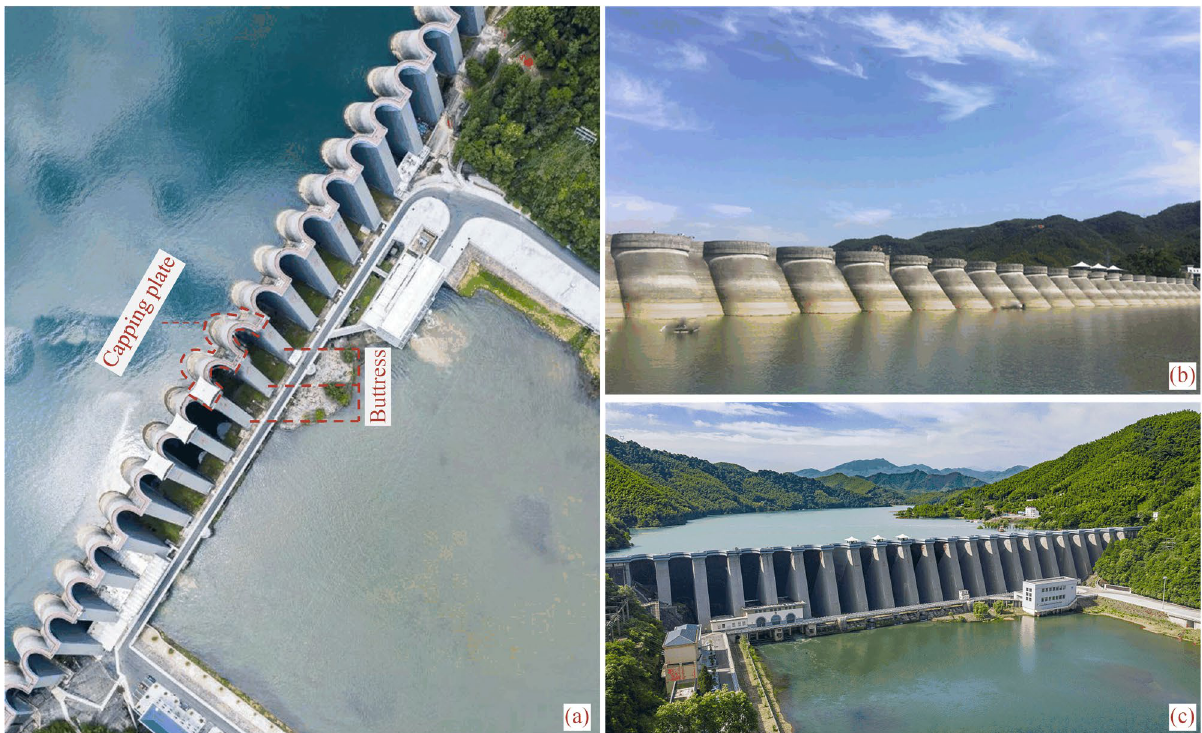
Figure 1. Foziling muli-arch dam: ( a ) top view; ( b ) upstresm view; ( c ) downstream